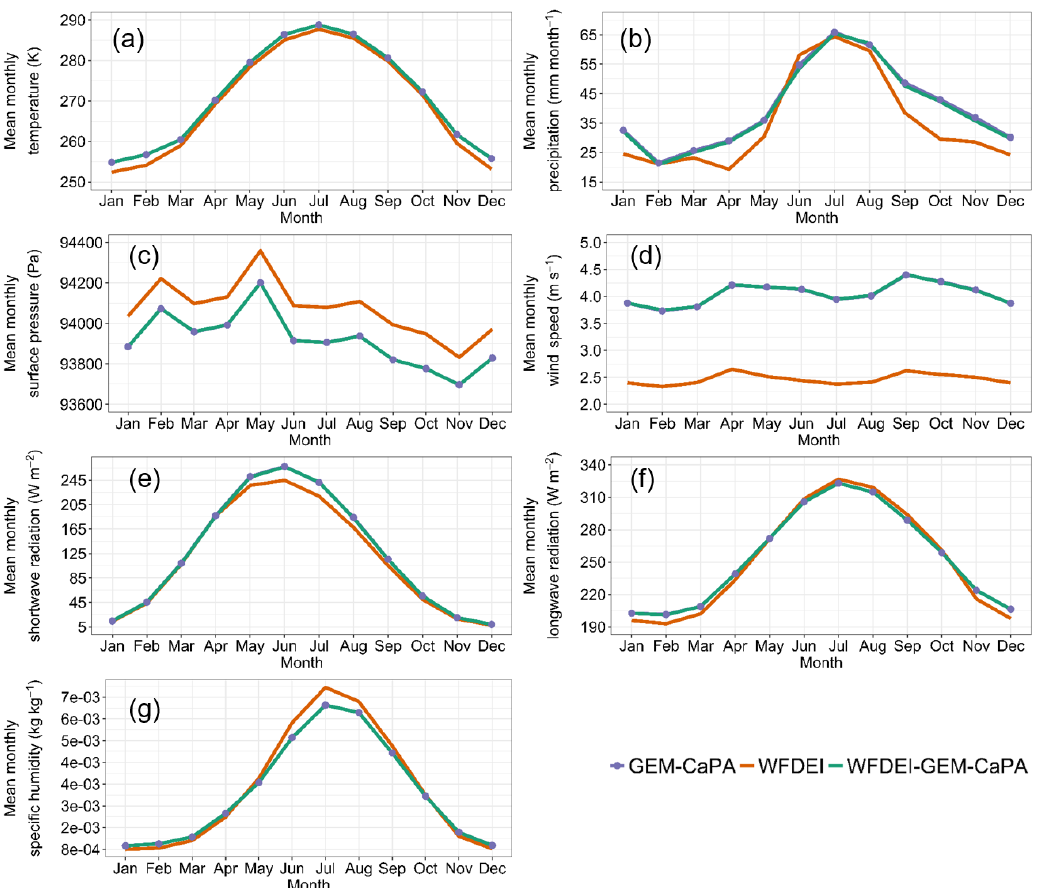
Figure 4. Seasonal cycle of GEM-CaPA (dark slate blue), WFDEI (orange), and WFDEI-GEM-CaPA bias-corrected data (green) for air tem- perature (a) , precipitation (b) , surface pressure (c) , wind speed (d) , shortwave radiation (e) , longwave radiation (f) , and specific humidity (g) during the fitting period